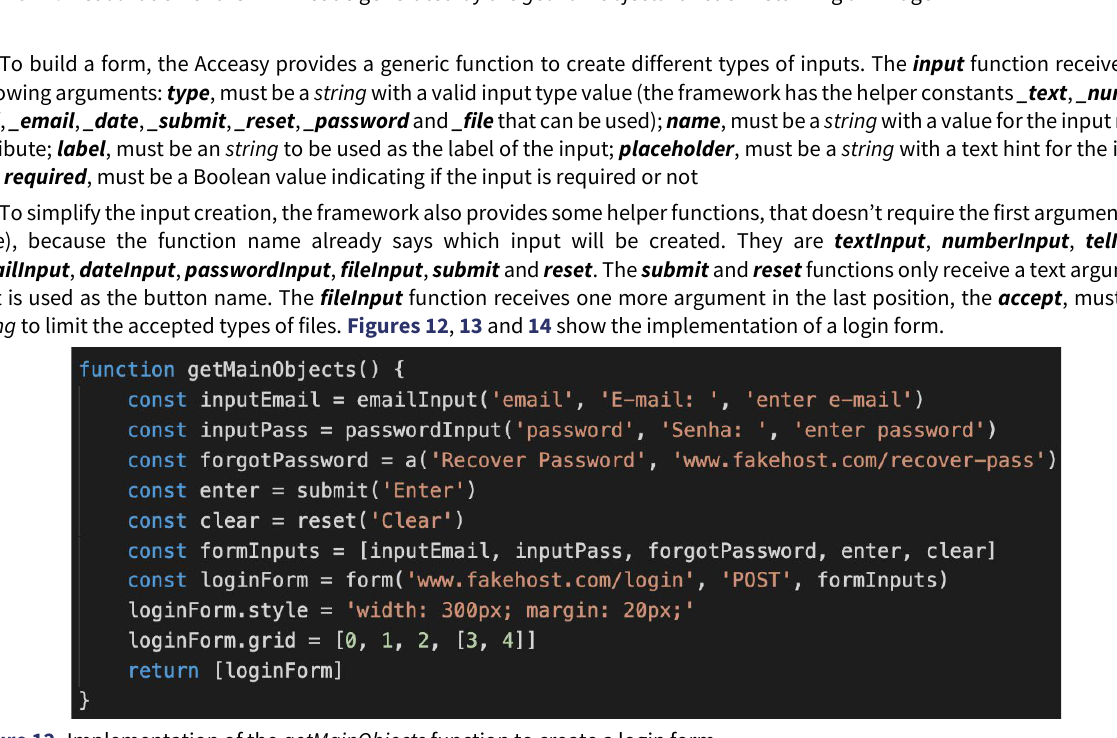
Figure 11. Visualization of the HTML code generated by the getMainObjects function returning an